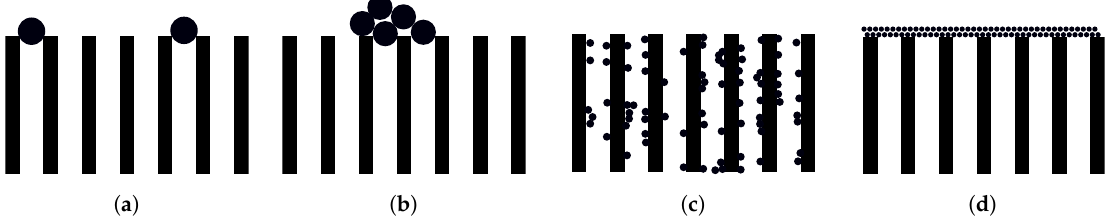
Figure 6. Four common types of blockage. ( a ) Complete blockage; ( b ) Intermediate blockage; ( c ) Standard blockage; ( d ) Cake blockage.